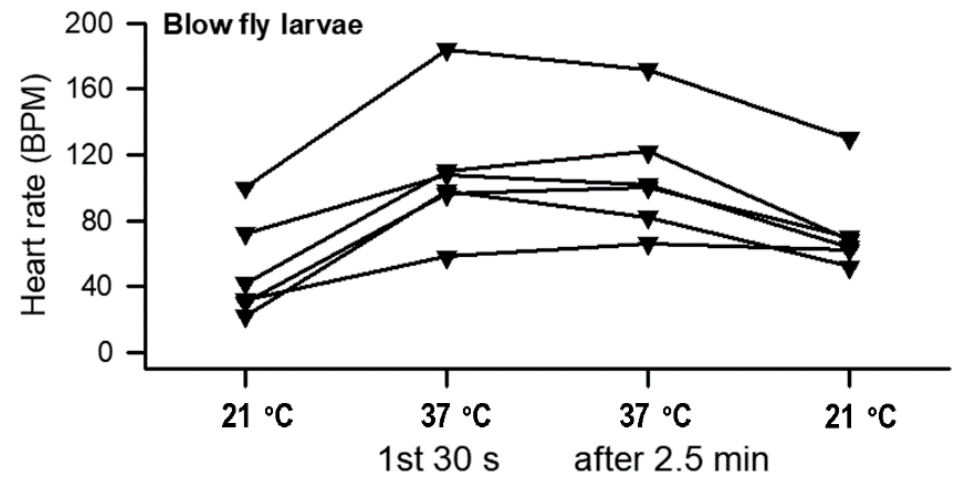
Figure 6. Heart rate in dissected and pinned out L. sericata to expose them to saline. The hearts were devoid of hormonal factors in the dissected preparations and demonstrated an increase in rate with high temperatures ( p < 0.05, paired t -test 21 to the initial 37 °C).